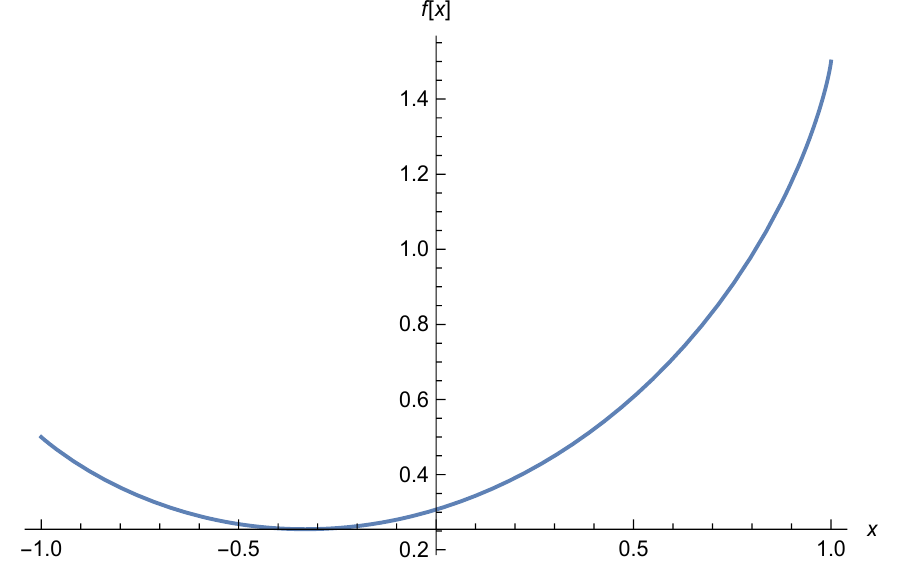
Figure 1 . The dependence of f ( x ) appearing in B 2 is displayed as a function of the cosine of the scattering angle x = cos (cid:18) s